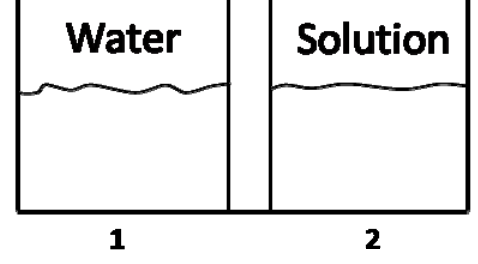
Figure 14. Schematic sketch of the osmosis system. The intermediate membrane is penetrable only for